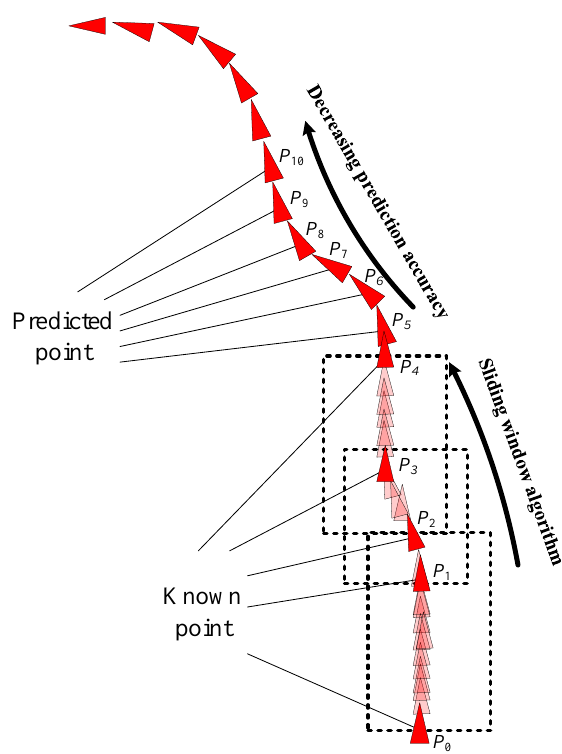
Figure 12. BI-LSTM-RNN trajectory prediction diagram.